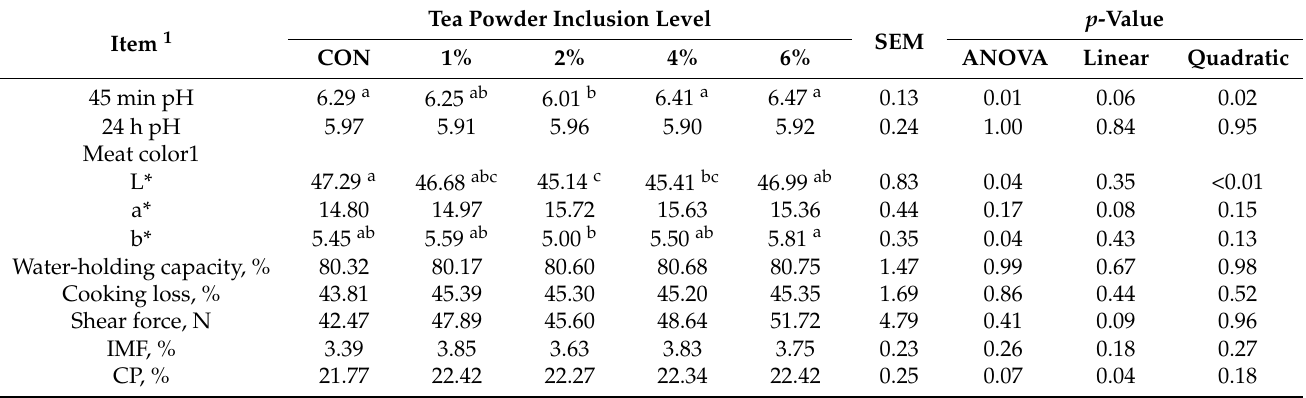
Table 6. Effects of dietary supplements with tea powder on meat quality of the